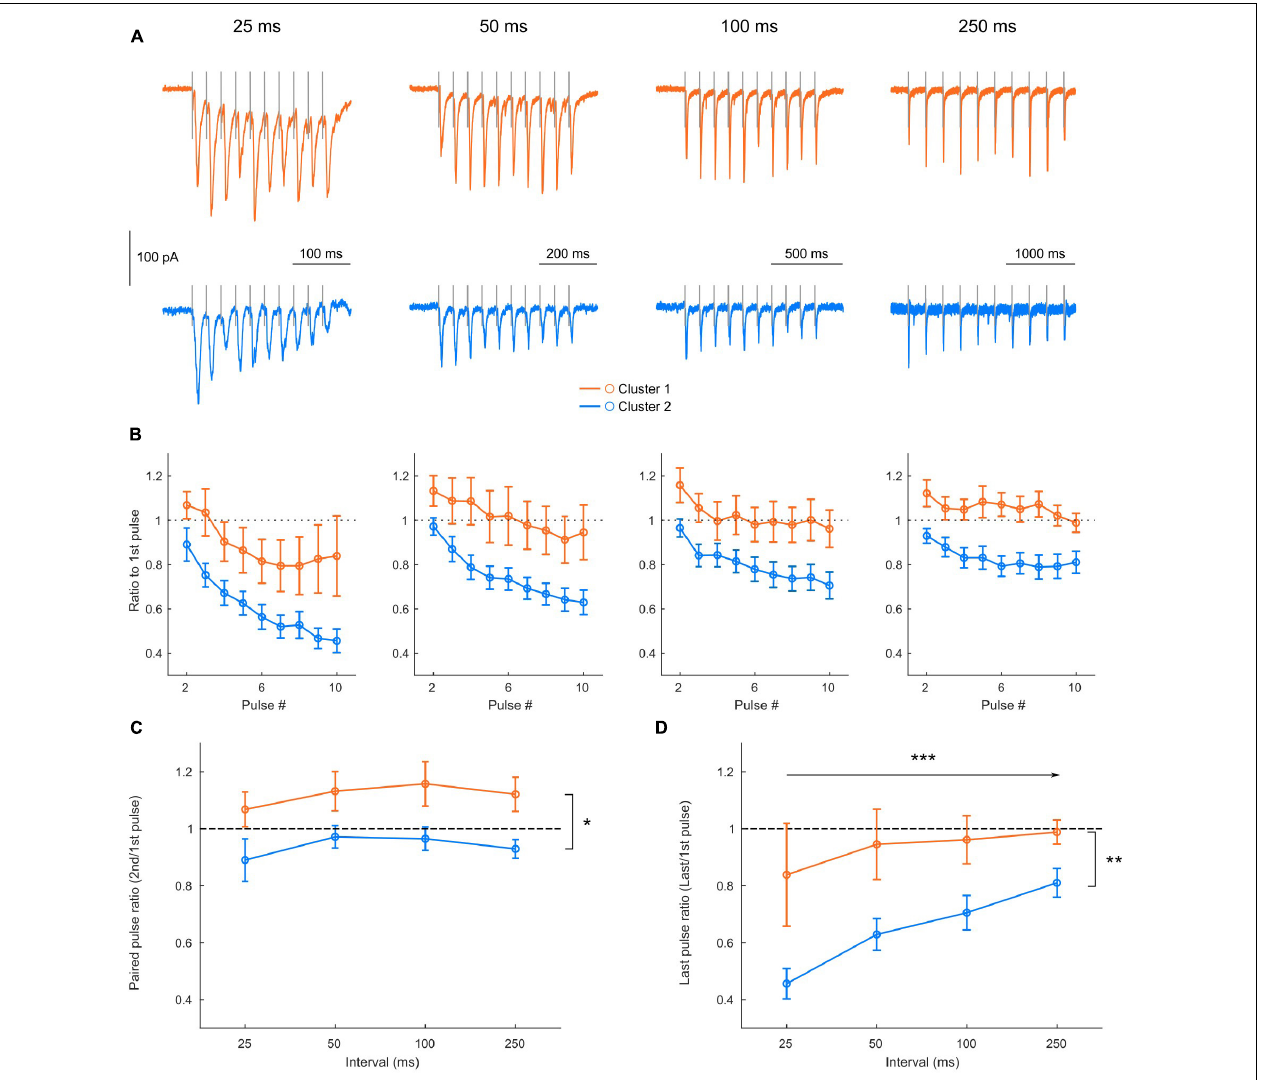
FIGURE 6 | Clusters display different short-term plasticity properties. (A) Example of EPSCs recorded in a cluster 1 (orange) and a cluster 2 (blue) neuron in response to trains of 10 stimulations, for increasing stimulation intervals. (B) Average amplitude of the EPSCs along the train (starting from the second EPSC) in cluster 1 (orange) and cluster 2 (blue) neurons, normalized in each neuron by the amplitude of the first EPSC of the train, for each stimulation interval (see 3-way ANOVA results in Results). (C,D) Influence of the stimulation interval on the first paired pulse ratio [ C: EPSC2/EPSC1; 2-way repeated measures ANOVA, effect of cluster F (1, 20) = 7.23, p = 0.0141; Effect of interval F (3, 60) = 1.7040, p = 0.1758; Interaction F (3, 60) = 0.0713, p = 0.9751] and on the last pulse ratio [ D: EPSC10/EPSC1; 2-way repeated measures ANOVA, effect of cluster F (1, 20) = 8.20, p = 0.0096; Effect of interval F (3, 60) = 10.01, p < 0.0001; Interaction F (3, 60) = 1.66, p = 0.1849]. All data: mean ± SEM. * p < 0.05; ** p < 0.01; *** p <